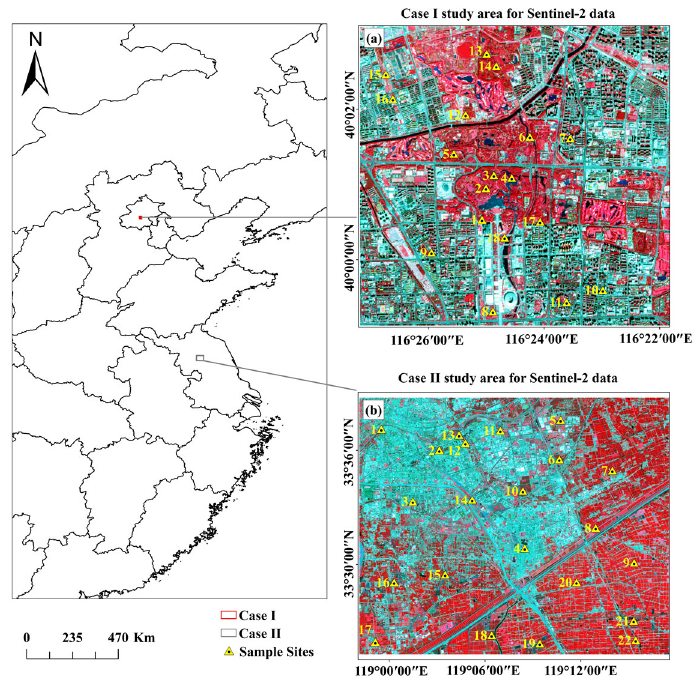
Figure 2. Spatial distribution of the study areas where ( a ) Case I is located in the megacity, Beijing and ( b ) Case II is located in part of Huai’an, China. The background image is false color composite with Sentinel ‐ 2 (RGB: band 8, 4, 3) where vegetation is red, water is dark blue, and cities are blue–gray .